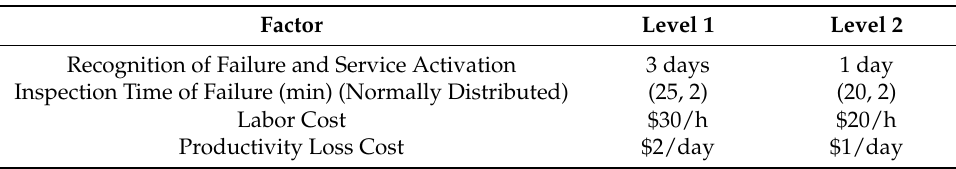
Table 7. Maintenance factors.